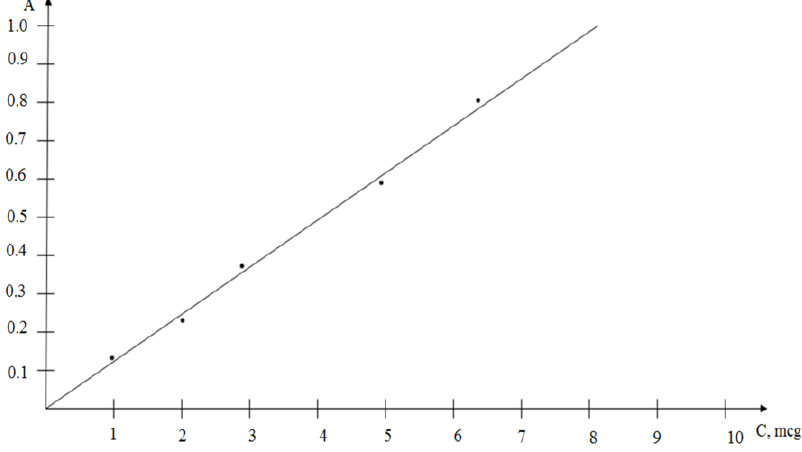
Fig. 8. Linear dependence of optical density on concentration of fructose